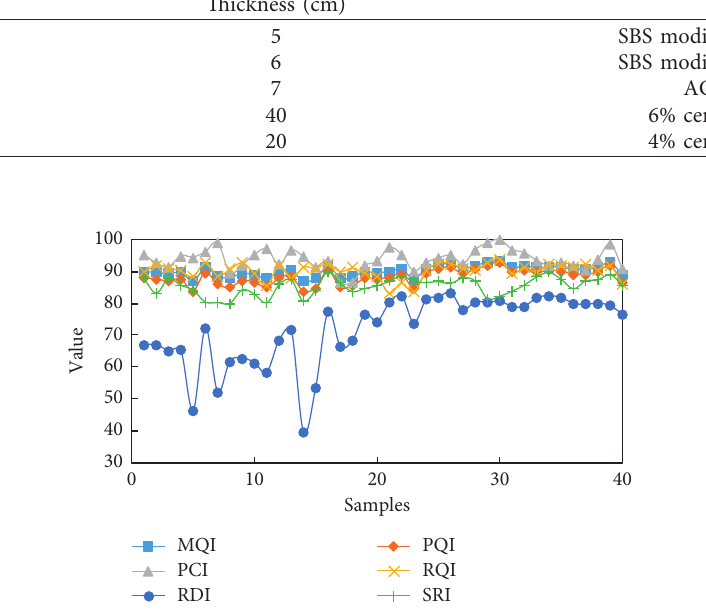
Figure 4: Collected data of pavement condition evaluation.